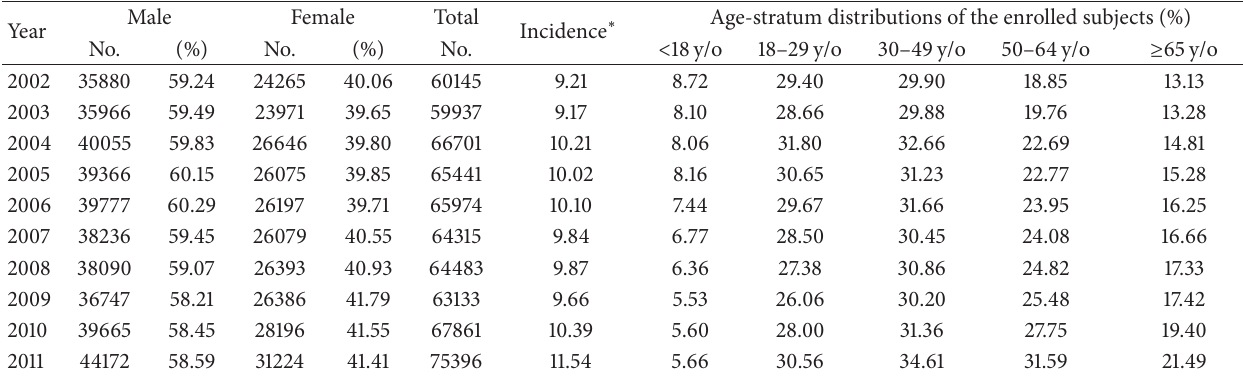
Table 1: Basic characteristics of the enrolled population, 2002–2011.